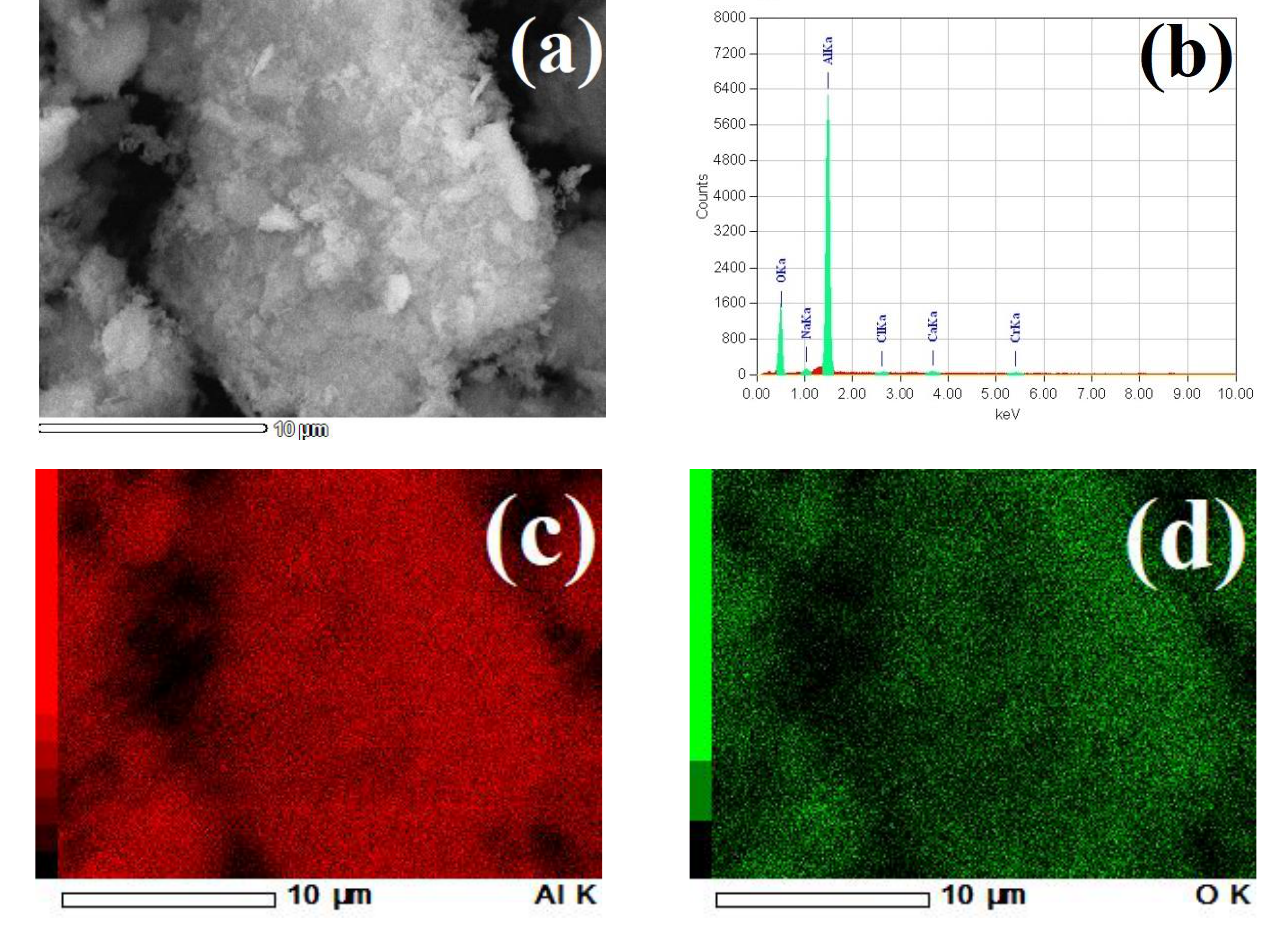
Figure 9. SEM image of the purer Al 2 O 3 sample after water washing and calcination at 800 °C ( a ), the EDX spectrum for the image region ( b ), as well as aluminum ( c ) and oxygen ( d ) distribution maps.